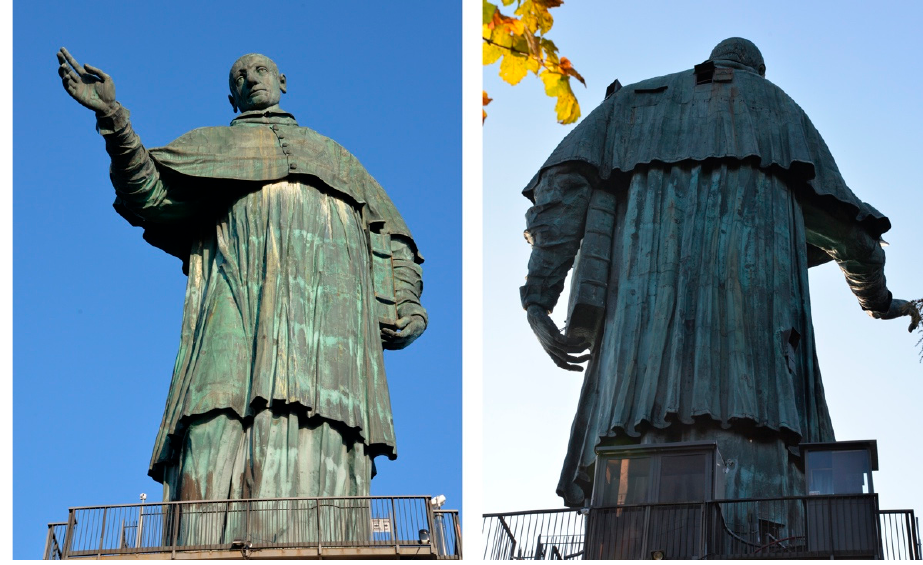
Figure 1. The Colossus of San Carlo Borromeo (1538–1584), Arona (Italy), called San Carlone .